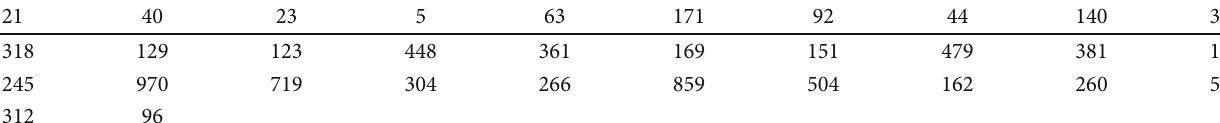
Table 6: The number of claims of losses from private passenger automobile insurance policies in United